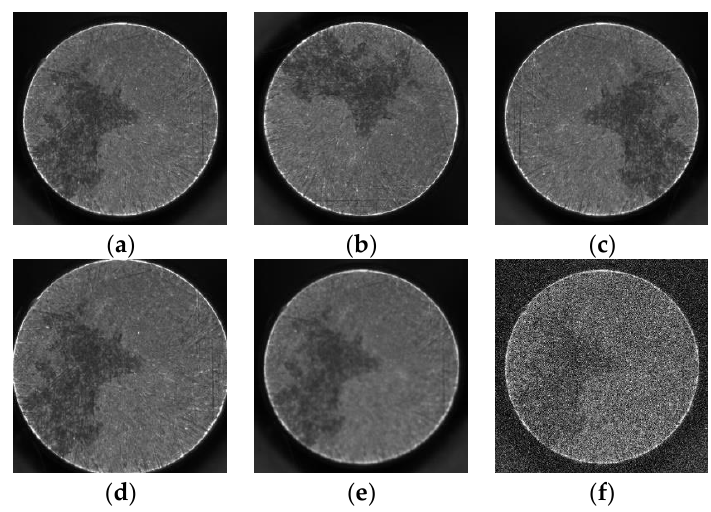
Figure 8. Data augmentation: ( a ) Original image; ( b ) rotation; ( c ) image flipping; ( d ) center cropping; ( e ) adding blur, and ( f ) adding gaussian noise.